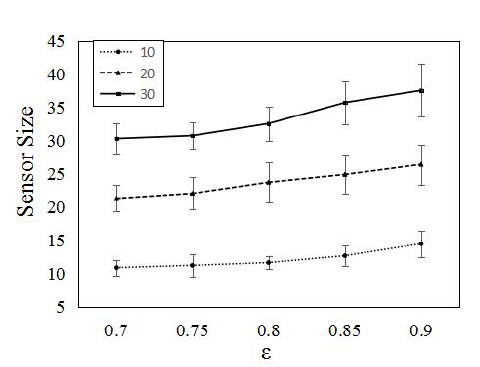
Figure 10. Comparing numbers of active sensors for different target sizes and coverage requirements in a 200 m × 200 m area. We randomly deployed 400 sensors in the area and set the minimum detection probability p min = 0.2. The numbers of targets are 10, 20 and 30.